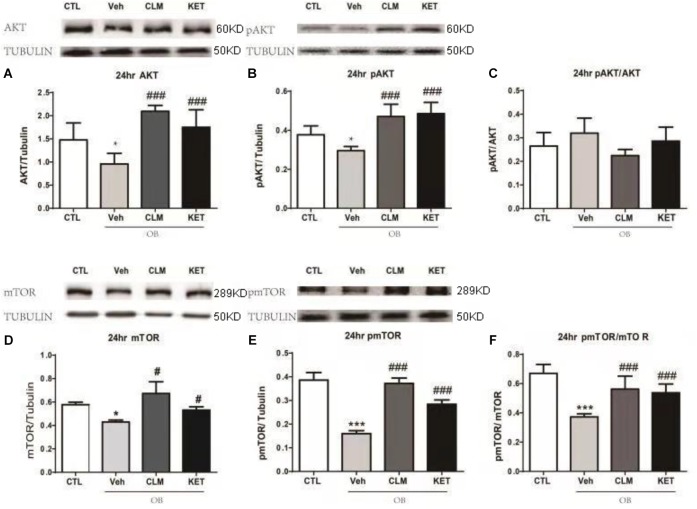
Western blotting detection of expressions of AKT and mTOR signaling in the PFC of OB mice at 24 h post a single administration of CLM or KET. (A) AKT, ANOVA, F(3,23) = 15.91, p < 0.0001. (B) pAKT, ANOVA, F(3,23) = 19.15, p < 0.0001. (C) pAKT/AKT, F(3,23) = 3.331, p < 0.05. (D) mTOR, ANOVA, F(3,19) = 17.62, p < 0.0001. (E) pmTOR, ANOVA, F(3,19) = 106.5, p < 0.0001. (F) pmTOR/mTOR, F(3,19) = 19.34, p < 0.0001. Data are means ± SEM, and n = 5–6/group. ∗p < 0.05, ∗∗p < 0.01, ∗∗∗p < 0.001, compared to CTL; #p < 0.05, ##p < 0.01, ###p < 0.001 compared to Veh.